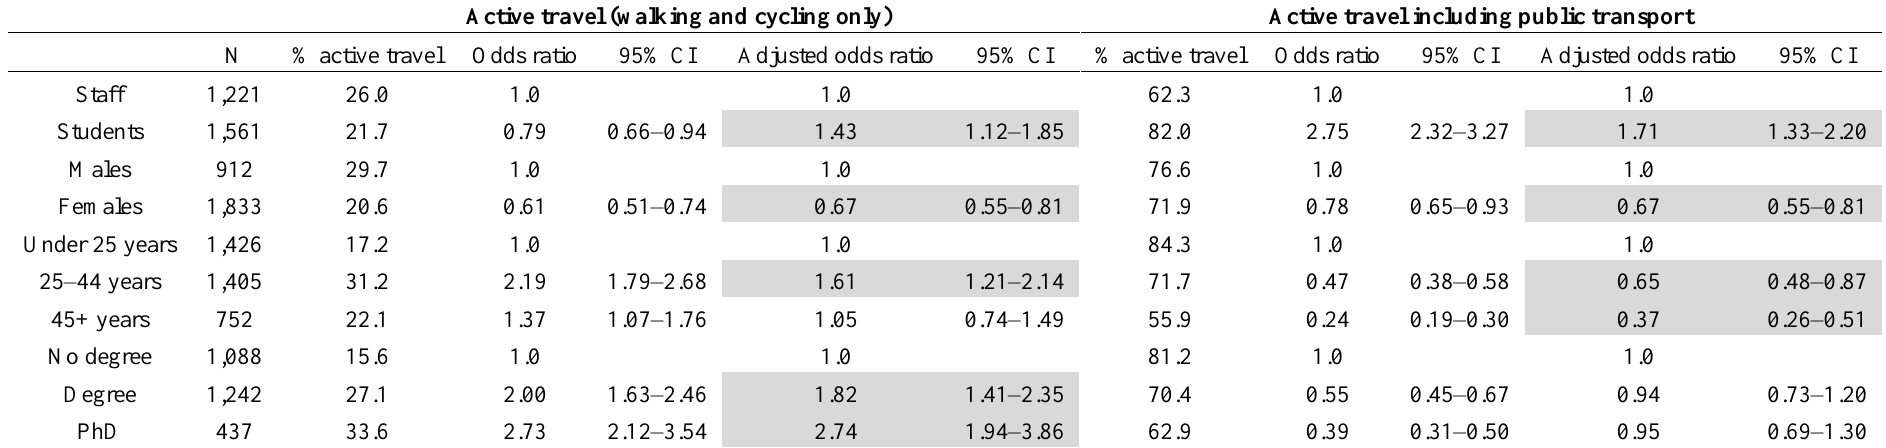
* Shading indicates statistically significant association; ** The Hosmer–Lemeshow test of goodness of fit excluding public transport ( p < 0.001); The Hosmer–Lemeshow test of goodness of fit including public transport ( p =